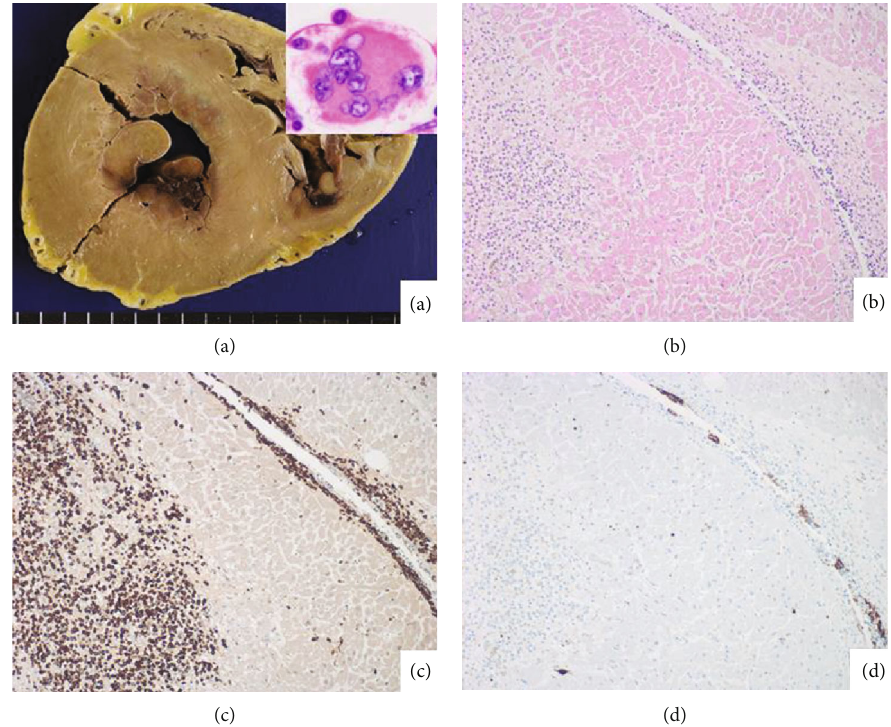
Figure 3: The heart involved by leukemic cells ((a) cut surface of the heart after formalin fi xation; (b) H&E, inset: high-powered view; (c) MPO; (d) CD61). Grossly, the subendocardial myocardium circumferentially appears dark-colored. Microscopically, the MPO-positive leukemic blasts invade both the myocardium and endocardium. CD61-positive megakaryocytic cells are distributed in the endocardium. The inset demonstrates high-powered H&E morphology of a subendocardial located megakaryocyte. The in fi ltrating blasts replace the cardiomyocytes. Neither granulation tissue reaction nor fi brosis is seen in the involved myometrium.